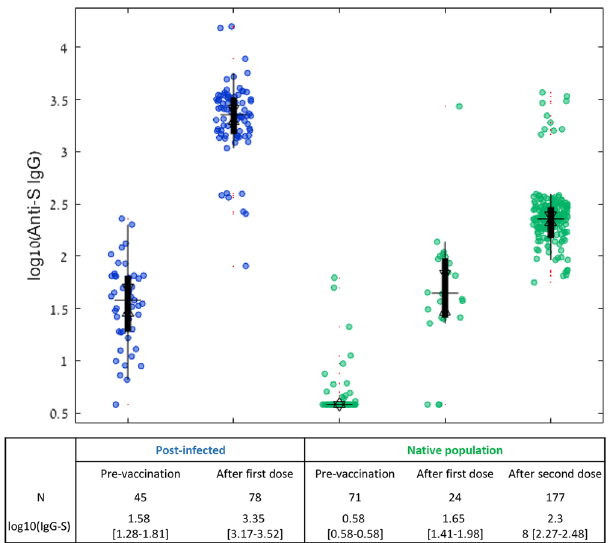
Figure 2. Serological response to BNT162b2 mRNA COVID-19 vaccine in post-infected individuals and naive population. The boxplot’s central mark indicates the median, and the bottom and top edges of the box indicate the 25th and 75th percentiles, respectively. p = 0.307 between the post-infected pre-vaccination group and the naïve population after the first dose, otherwise p < 0.0001.